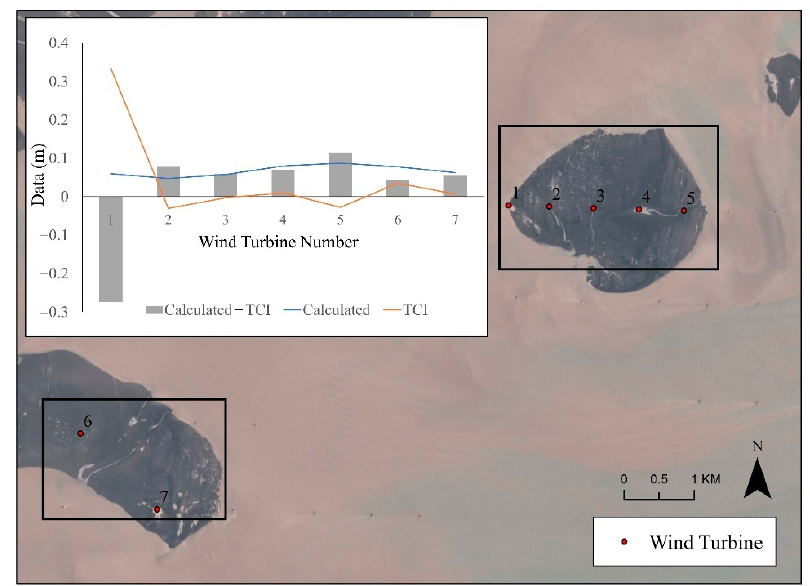
Figure 8. Comparison with the results calculated by semitheoretical formulas.